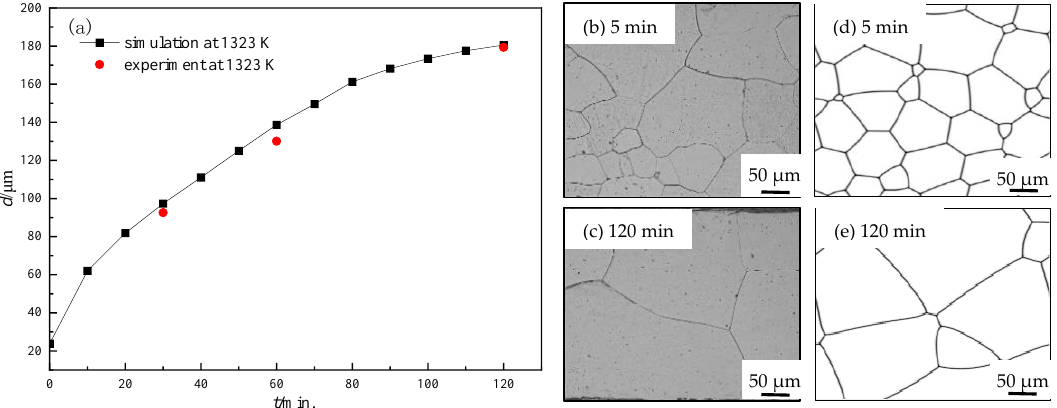
Figure 2. Comparison of simulated and experimental results for the Fe-3%Si steel at 1323 K. ( a ) Av- erage grain size, ( b , c ) microstructures of testing samples at 5 min and 120 min, ( d , e ) simulated microstructures at 5 min and 120 min.